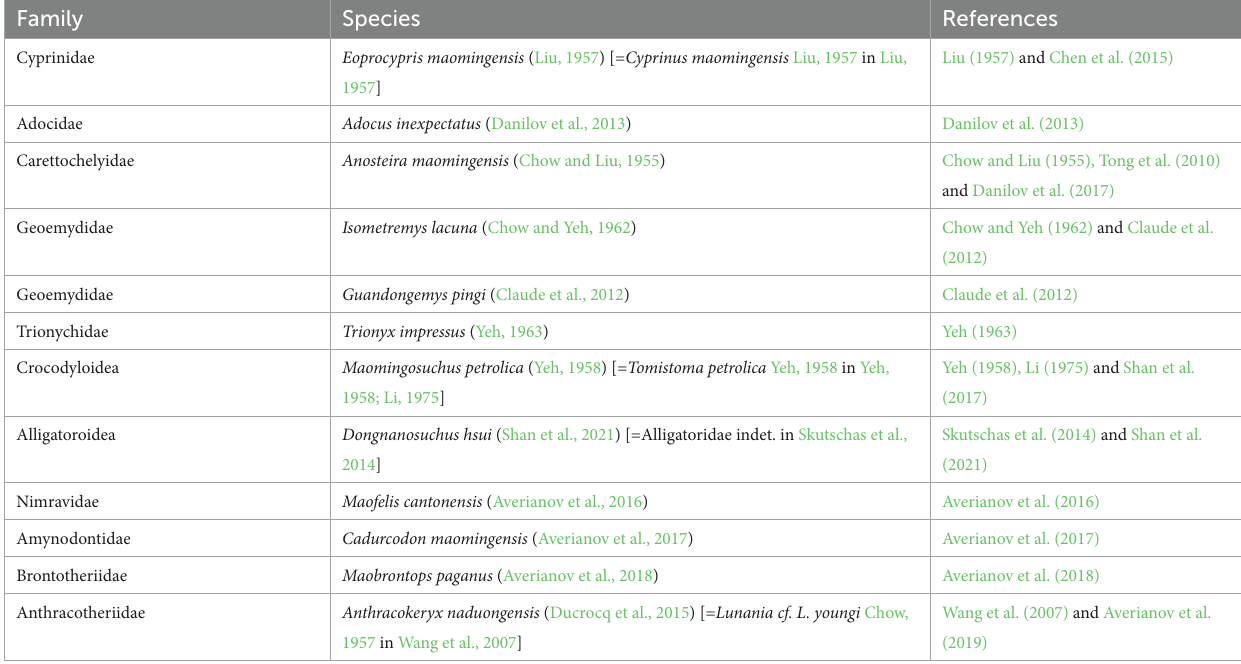
TABLE 2 List of the vertebrates from the upper Eocene Youganwo Formation at Maoming locality, Guangdong Province, China. Family